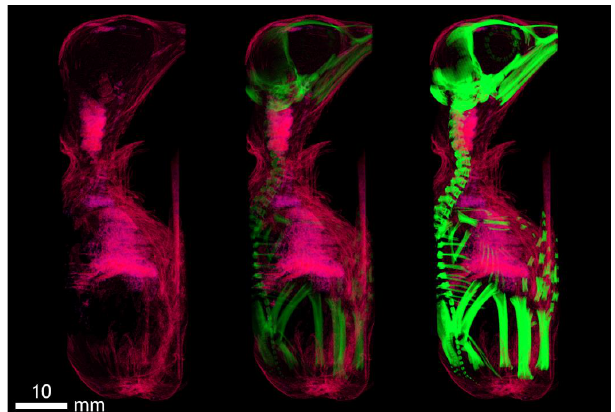
Figure A2. Dyed 19-day-old chicken (acquisition at anode voltage 40 kV, contrast agent ethanol). Imaging after 5 days of ethanol fixation with incipient soft tissue contrast of the trachea, diaphragm, and heart muscle. The contrast in this phase of fixation also corresponds to the density of the surface structures of skin derivatives (feathers).